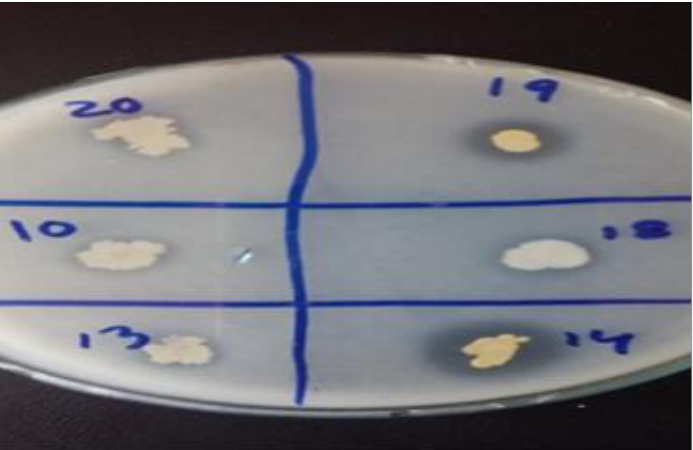
Figure 2. E ffi cient strains showing halozones for phosphate solubilization, Halozone 14 = RP08 ( Enterobacter cloacae ), Halozone19 = RP01 ( Bacillus subtilis